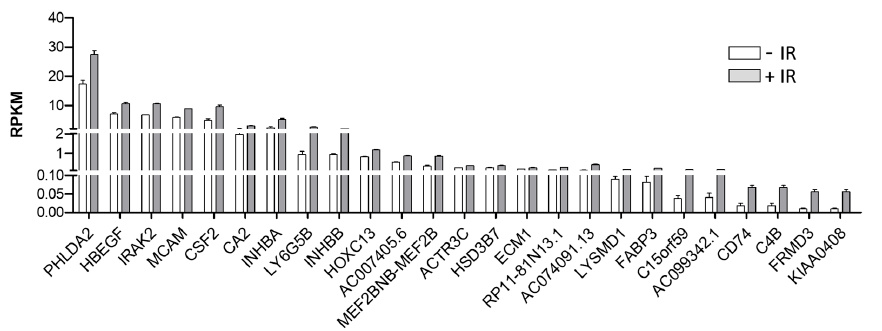
Figure 2. IRAK2 is induced by ionizing radiation in OML1 cells. Expression of post-irradiation upregulated genes. The mean expression of the 25 most significantly upregulated genes in IR-treated OML1 cells compared to non-treated cells. The plot shows the RPKM values for each transcript in two independent replicated experiments.